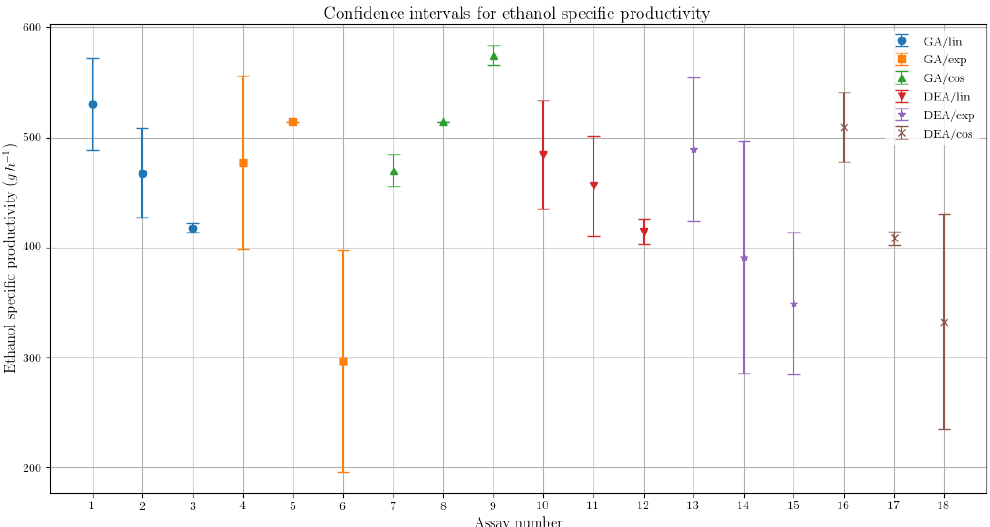
Figure 4. Confidence interval comparison between the assays for the specific ethanol productivity, presenting the variability respective to each optimization algorithm and feed rate parametrization.